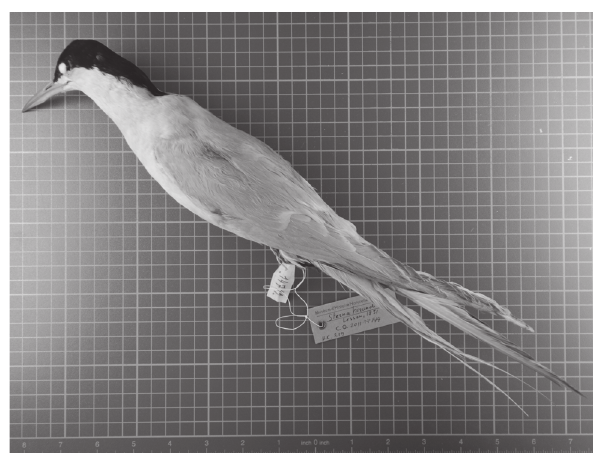
Figure 1. South American Tern Sterna hirundinacea , lectotype MNHN C.G. 1989-278 collected by Augustin de Saint-Hilaire at Laguna, Santa Catarina. Photograph: Anne